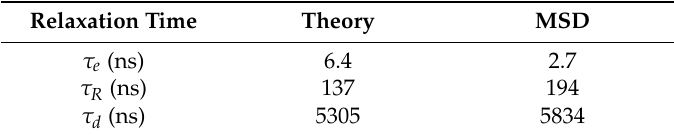
Figure 2. Characteristic timescales as functions of molecular length. Power-law exponents agree well with experimental observations. Table 2. The three relaxation times for the C 1000 H 2002 melt calculated according to reptation theory and segmental mean-square displacement (MSD) data.